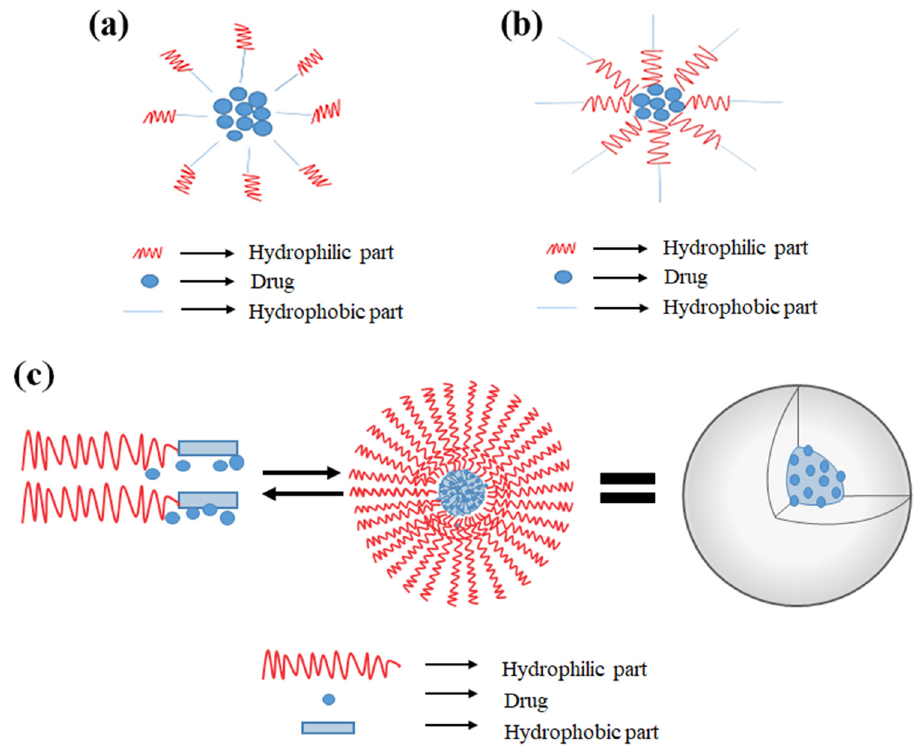
Figure 2. Schematic representation of supramolecular structure of nanomicelles ( a ) regular nanomi- celles, ( b ) reverse nanomicelles, ( c ) polymeric micelles. Reproduced with permission from ref. [32]. Copyright 2021 by Wiley.